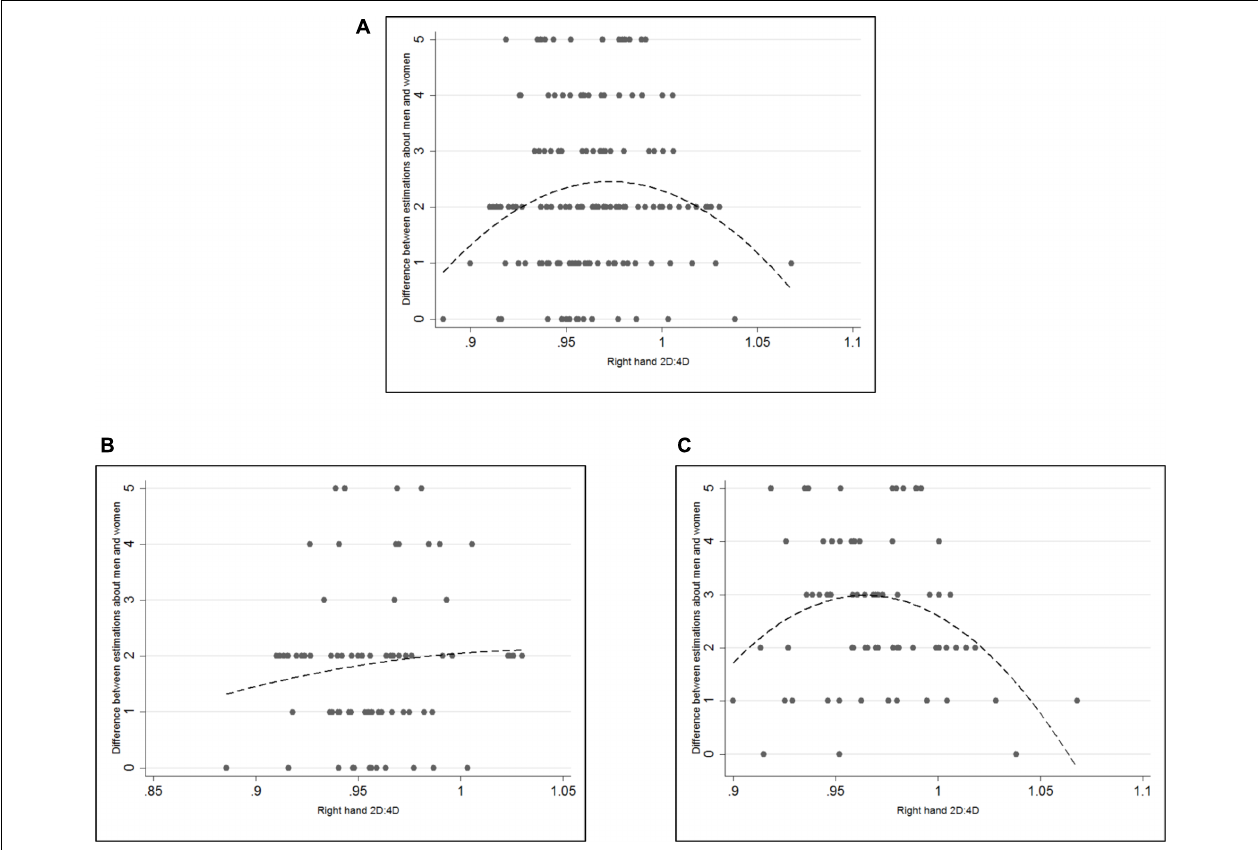
FIGURE 2 | Scatterplots of 2D:4D and gender bias in predictions. (A) Gender bias in predictions: difference between predictions for men and predictions for women. (B) Men’s gender bias in predictions. (C) Women’s gender bias in predictions. Dashed lines represent the fitted quadratic models without control variables. Both 2D:4D and 2D:4D-squared are significant at 99% significance level in (A) and at 95% significance level in (C) . Neither variable is significant in (B) .